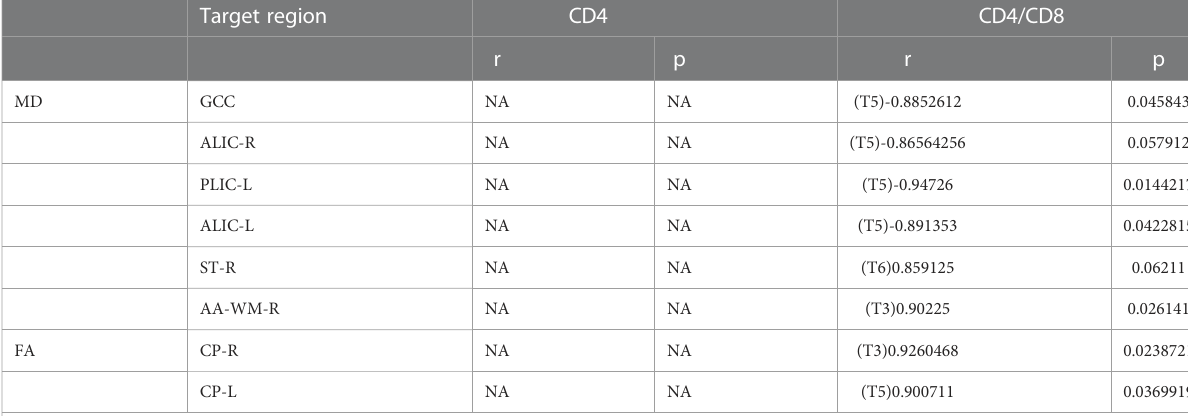
TABLE 1 The correlations between DTI metrics and clinical tests with regular cART